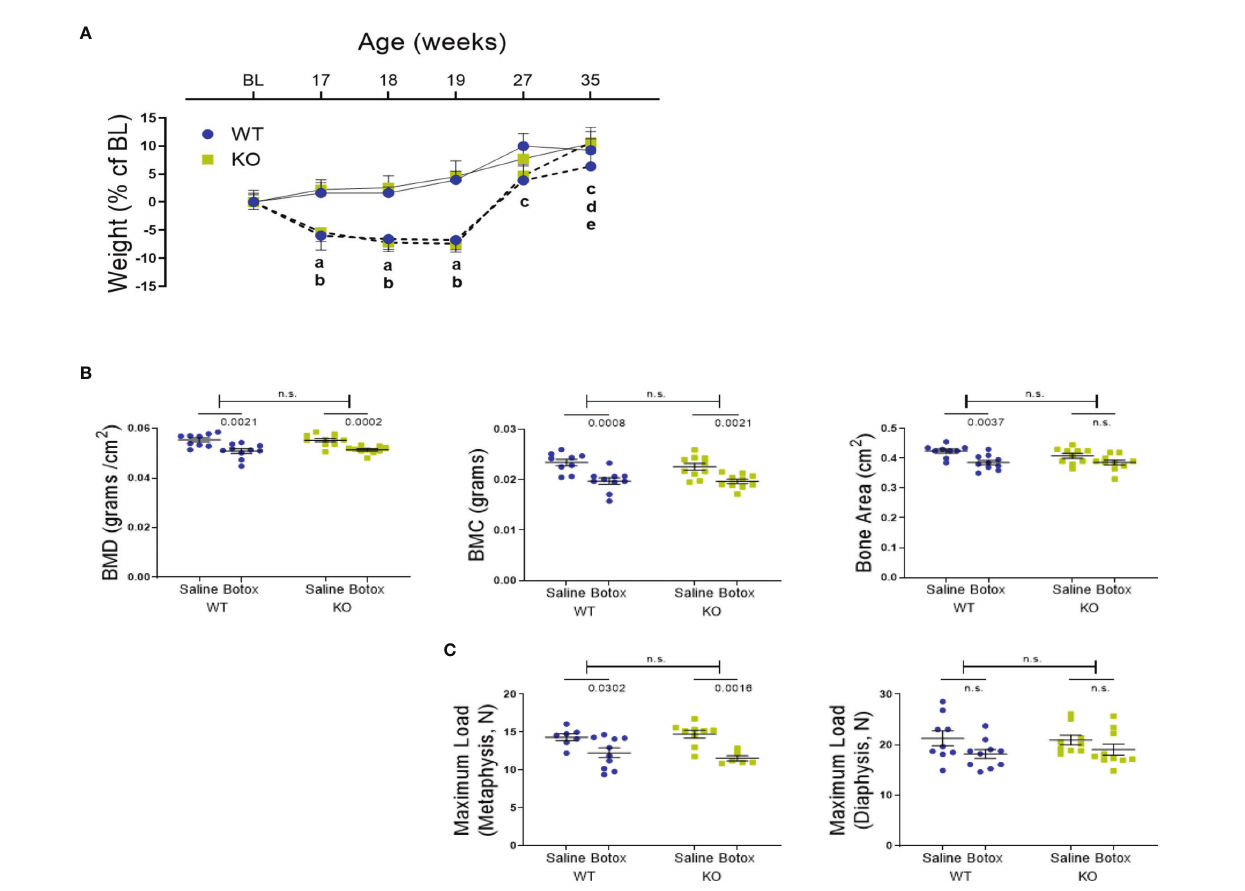
FIGURE 3 | (A) Weight changes during the unloading and remobilization phase, expressed as a percentage change from baseline body weight (BL, 16-week old) in WT and KO mice injected with either saline (solid line) or BTX (dotted line). Signi fi cant body weight reduction after BTX (a, P < 0.05 in WT and b, P < 0.05 in KO) compared to the saline controls and, in compared to the BL (c, P < 0.05 in WT; d, P < 0.05 in KO and e, P < 0.05 in BTX KO). Statistical signi fi cance was tested using 2- way ANOVA with Tukey ’ s test for multiple comparisons. Data shows mean ± SEM of n = 9 - 10 mice (WT) and 10 mice (KO) in each treatment group. (B) DXA assessments of femoral bone mineral density (BMD, grams/cm 2 ), bone mineral content (BMC, grams) and bone area (cm 2 ) and, (C) femoral maximum load (N), at metaphysis and diaphysis in both WT and KO at 19- weeks after BTX- induced muscle paralysis. Statistical signi fi cance was tested with either Student ’ s unpaired t-test/Mann-Whitney test (effect of KO) or, 2-way ANOVA (effect of BTX and KO) with Tukey ’ s test for multiple comparisons. n.s., no signi fi cance. Data shows mean ± SEM of n = 9-10 mice (WT) and 10 mice (KO) for DXA and n= 7-10 mice (WT) and 6-10 mice (KO) for bone